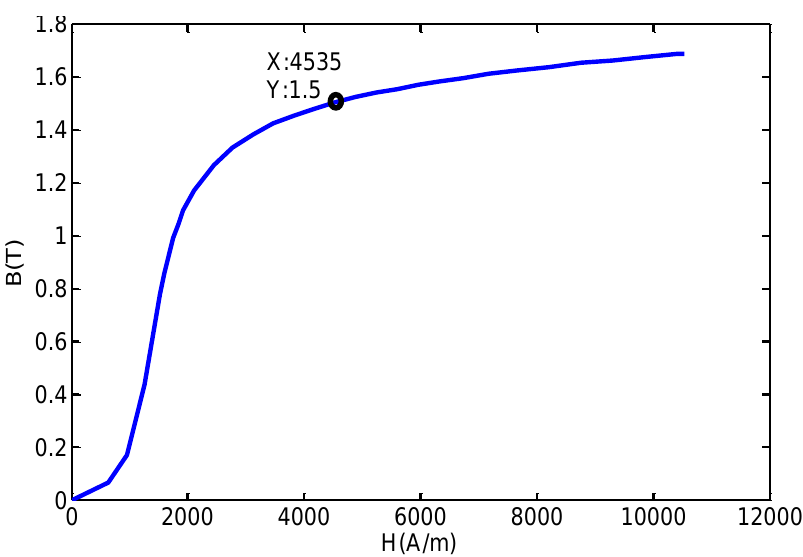
Figure 6. Magnetization curve of the cable.